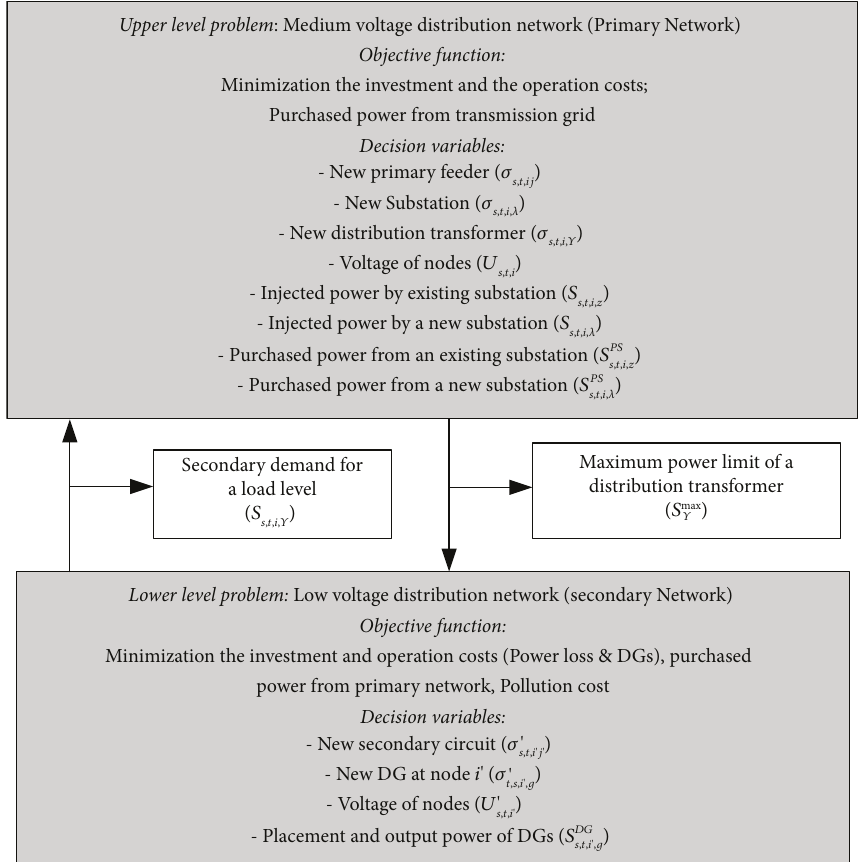
Figure 1: The structure of the proposed bi-level optimization